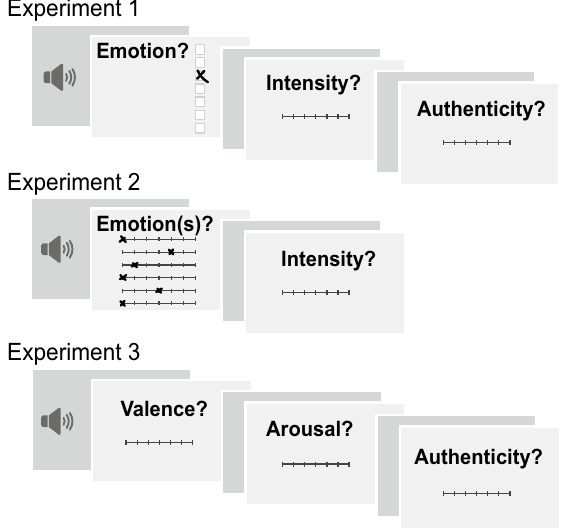
Figure 1. Experimental paradigm. Schematic of one experimental trial in each of the three tasks, the emotion categorization task (Experiment 1), the emotion rating task (Experiment 2), and the dimensional rating task (Experiment 3). The total session consisted of one practice block (4 trials) and ten experimental blocks (48 trials each), followed by a short questionnaire on sociodemographic information. All rating scales were end-to-end labeled 7-point Likert scales. The emotion labels were presented in random order across but fixed order within